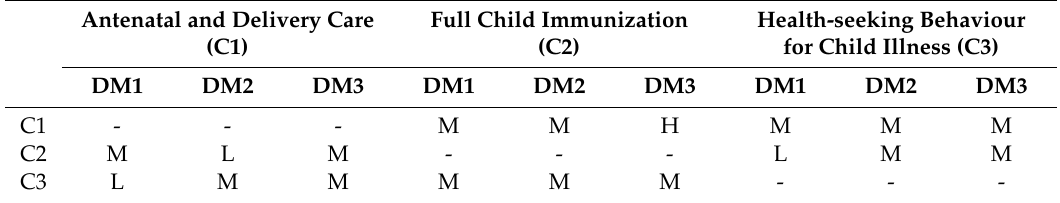
Table 5. Linguistic evaluations of decision makers for the dimension of maternal and child health. Antenatal and Delivery Care